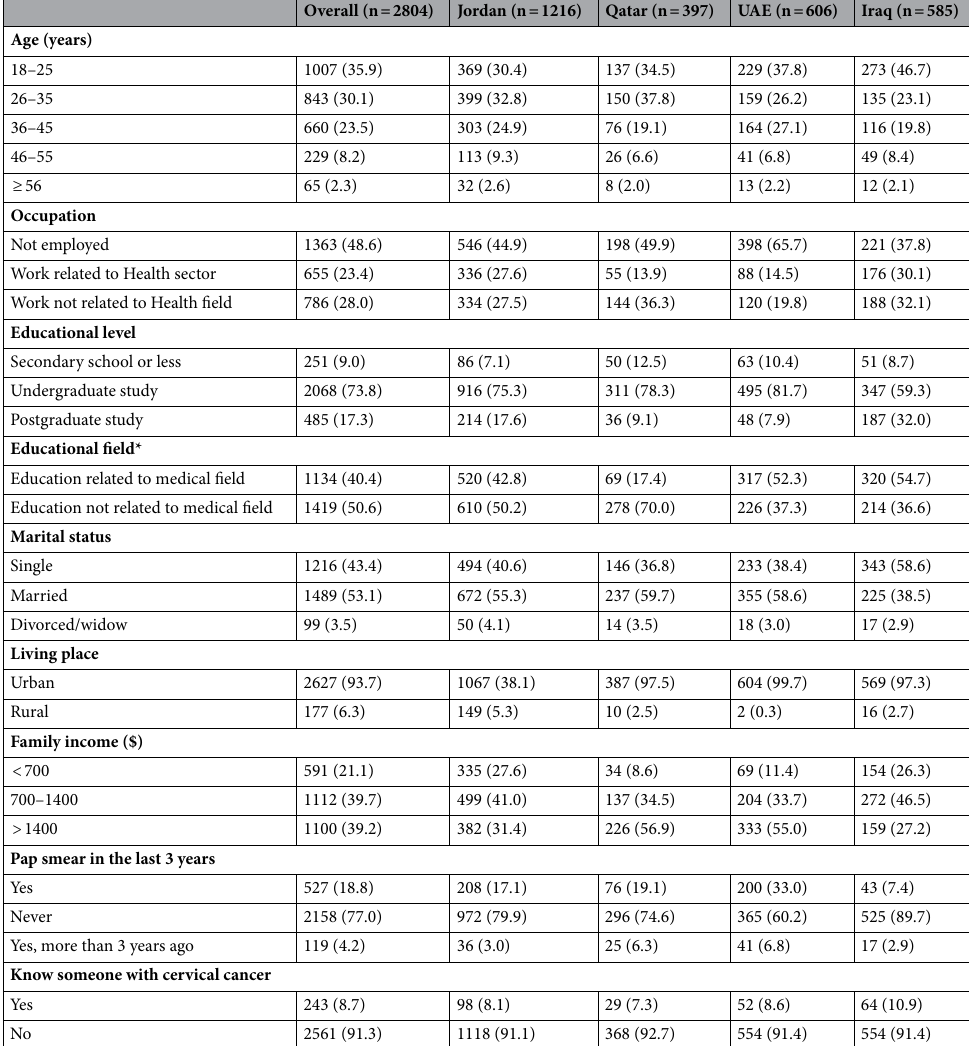
Table 1. Participants’ demographic data (n = 2804). *9% had educational level of secondary school or